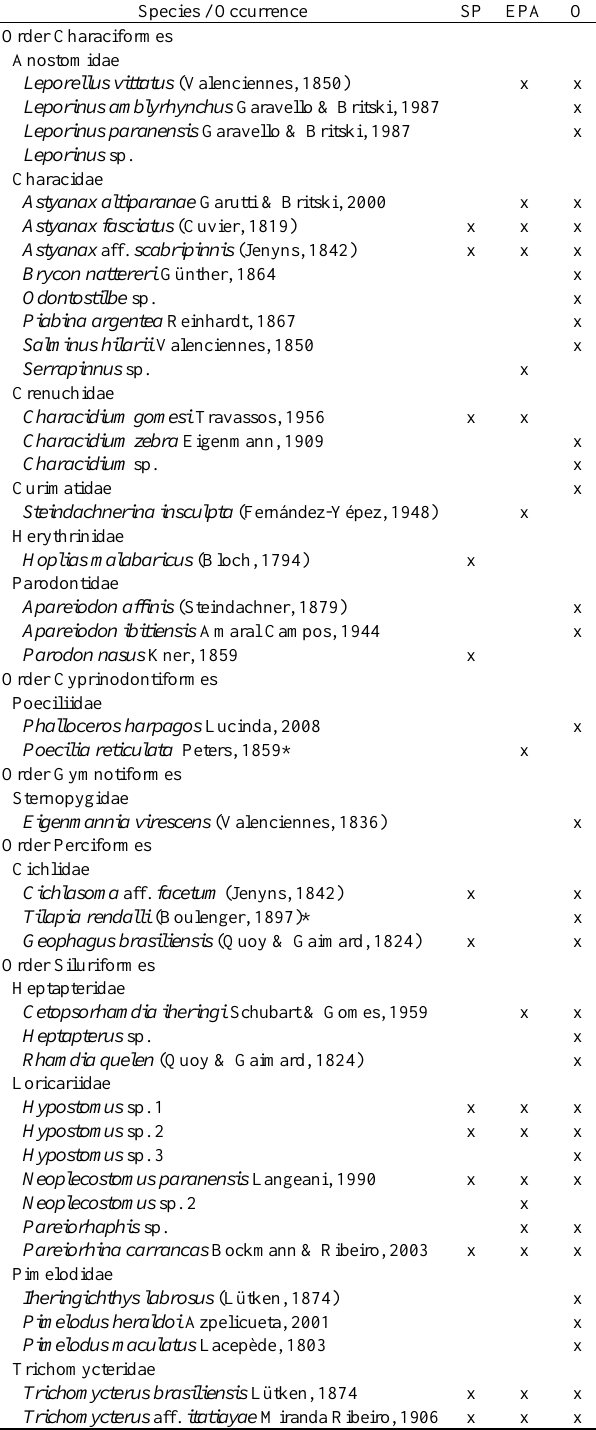
Table 2. Recorded species in the region of upper Capivari River (*exotic species; SP - proposed State Park, EPA - proposed Environmental Protection Area; O - outside the proposed conservation